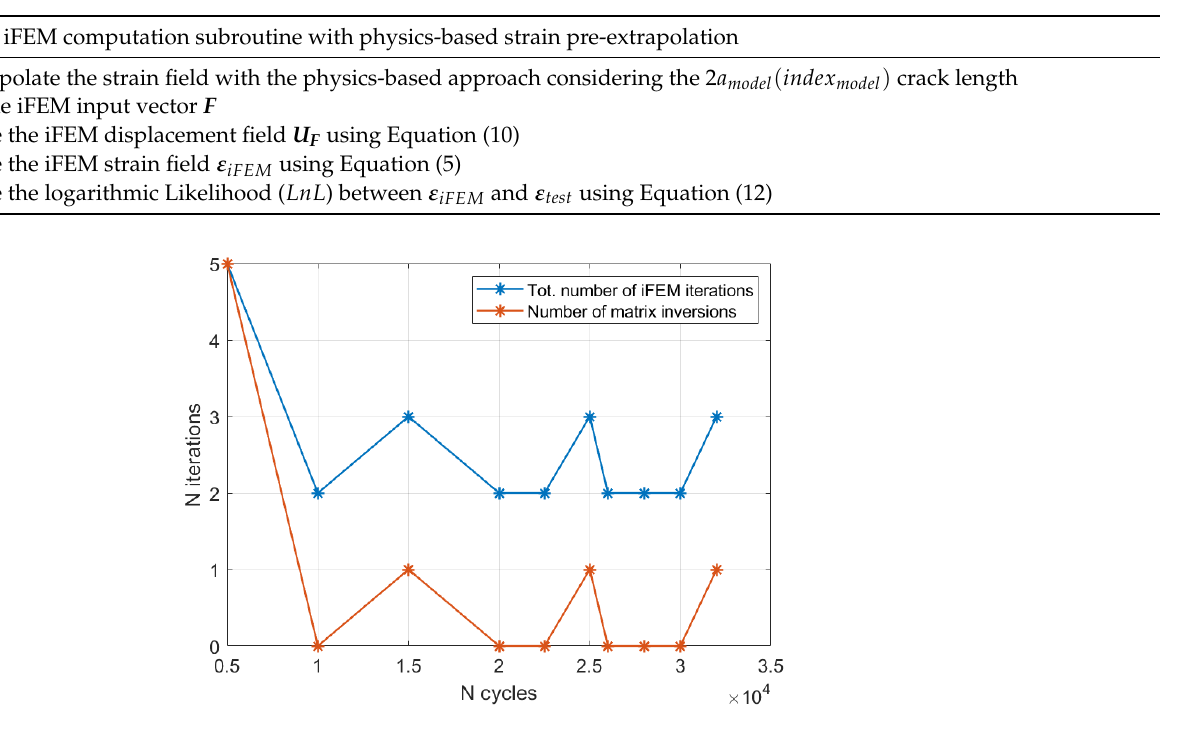
Figure 16. Total number of iFEM iterations and matrix inversions for the whole fatigue propagation.